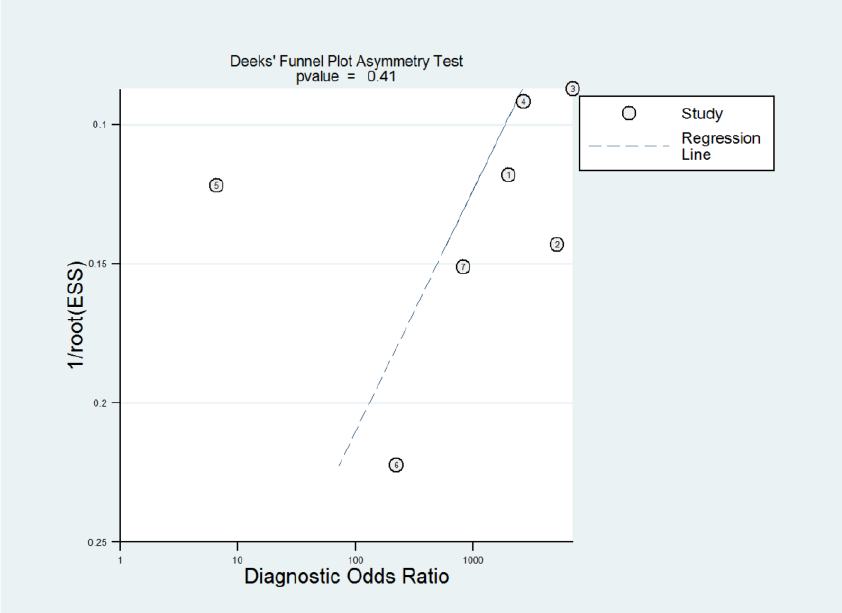
Figure 13. Publication bias regarding three-dimensional transvaginal